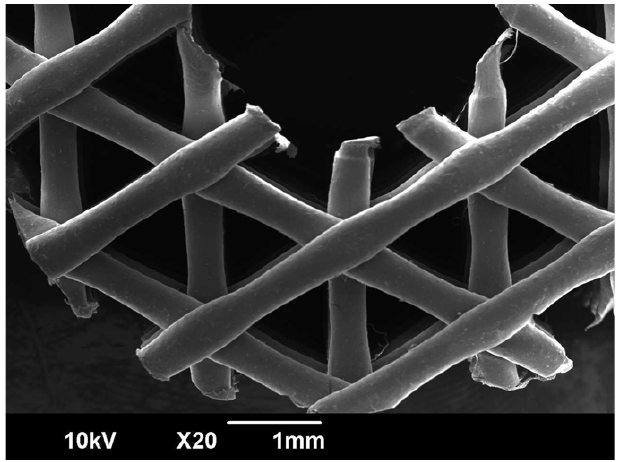
Figure 7. A scanning electron microscope image of Osteoplug TM —a PCL burrhole cover—demonstrating regular, highly interconnected porosity in the scaffold microarchitecture.